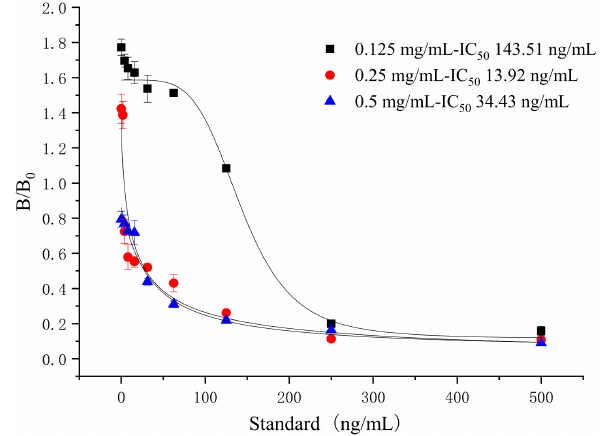
Figure 5. Dosage selection of the coating antigen for tylosin ( n = 3).